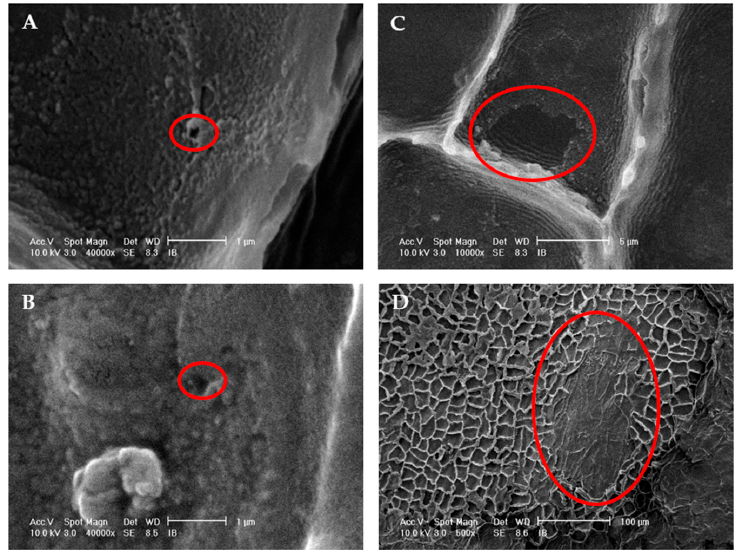
Figure 5. Primary effects ( A , B ), Secondary effects ( C ) and erosion after 20 min of sonication at 3 mm distance from the ultrasonic probe. A, B: 40,000 x ; C: 10,000 x ; D: 600 x .